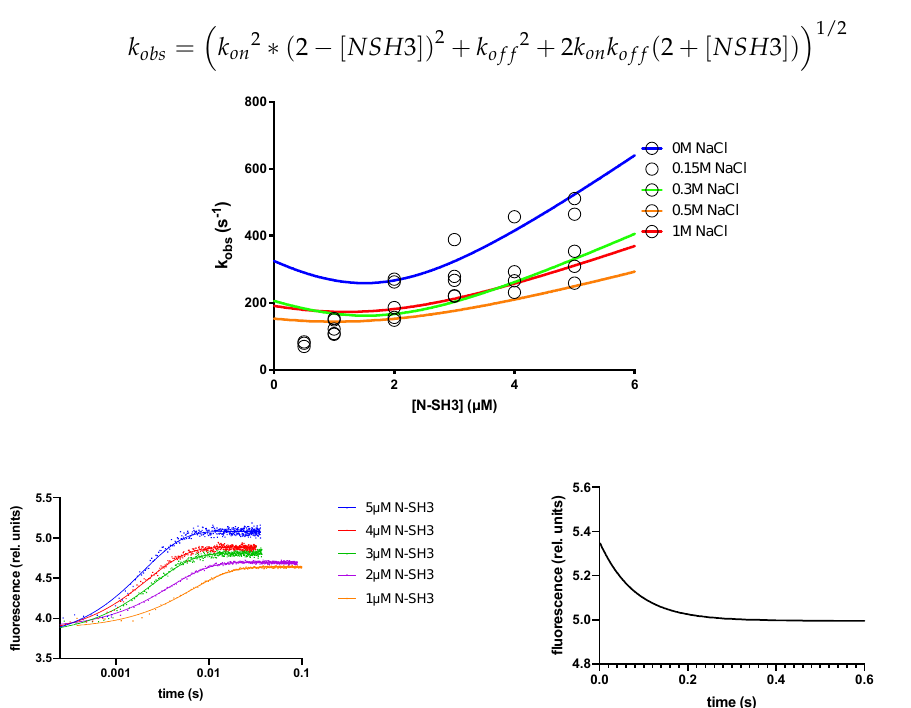
Figure 1. ( Top ) Kinetic binding experiments performed by mixing a constant concentration of dansylated C3G 277–296 peptide (0.5 µ M) versus increasing concentrations of N-SH3 in buffers containing different NaCl concentrations (see legend). Lines are the best fit to Equation (1). ( Bottom left ) Average kinetic traces obtained in binding experiments between dansylated C3G 277−296 peptide and different concentration of N-SH3 at different concentrations in buffer Hepes 50 mM pH 7.0. Lines are the best fit to a single-exponential equation. ( Bottom right ) Average displacement kinetic trace obtained mixing a preincubated complex of N-SH3 domain and dansylated C3G 277−296 peptide versus a high excess of nondansylated C3G 277−296 peptide in buffer Hepes 50 mM pH 7.0. Line represents the best fit to a single-exponential equation.